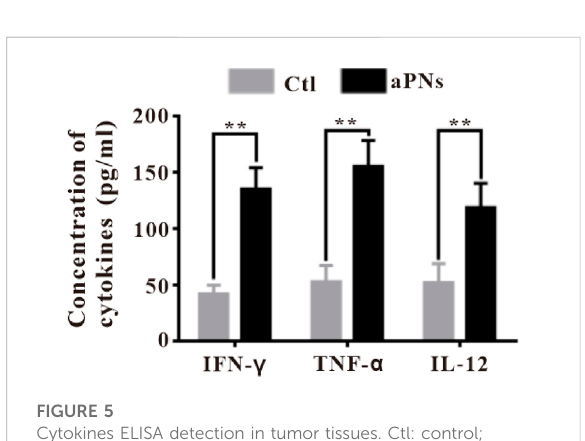
Cytokines ELISA detection in tumor tissues. Ctl: control; aPNs: aPLTm nanovesicles. Data are represented as mean ±